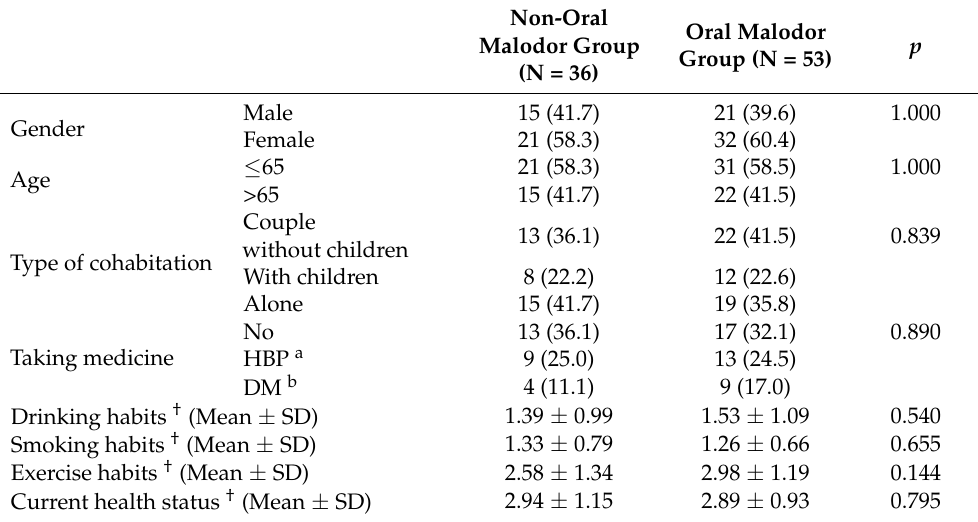
Table 1. Comparison of characteristics of the non-oral malodor group and the oral malodor group.